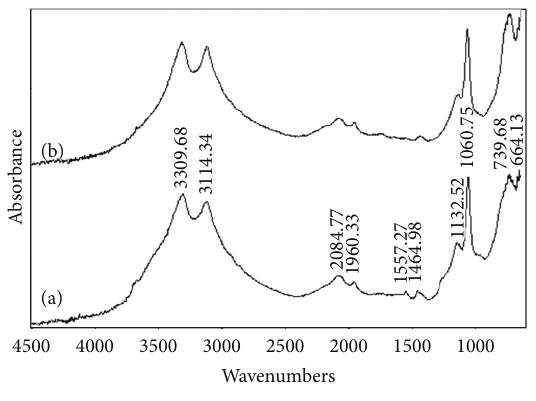
Figure 3: DRIFT spectra of (a) Al HT and (b) Al CHT .